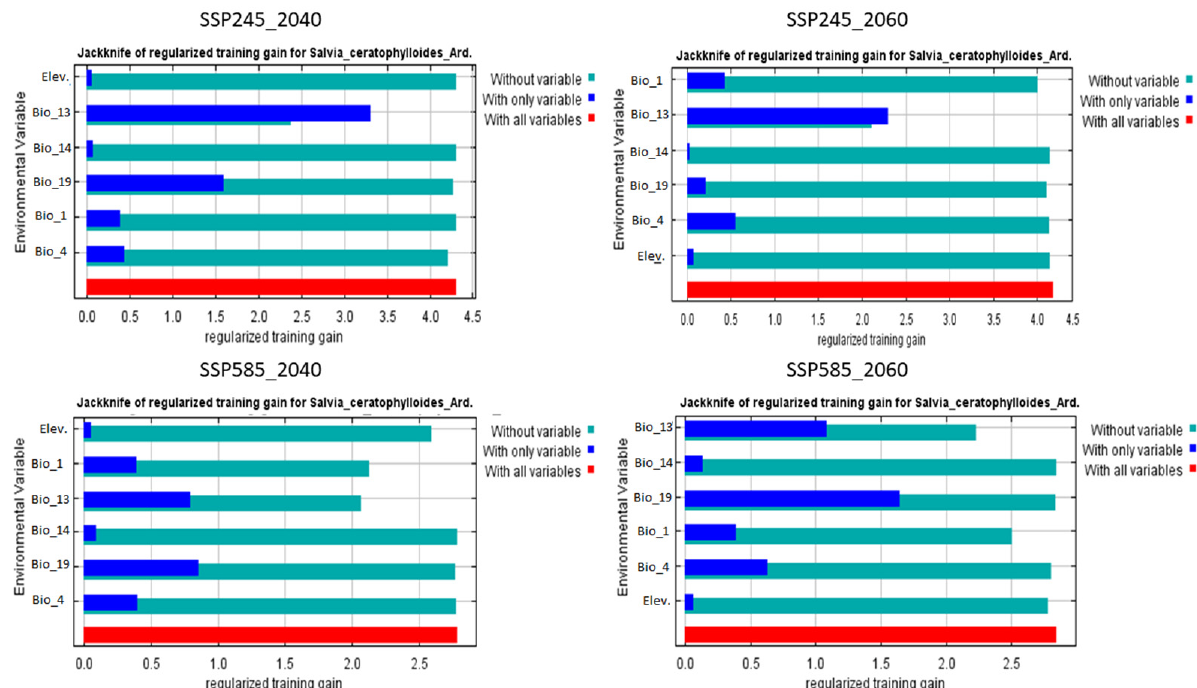
Figure 6. Relative predictive power of different environmental variables based on the jackknife of regularised training gain in MaxEnt models for Salvia ceratophylloides Ard.